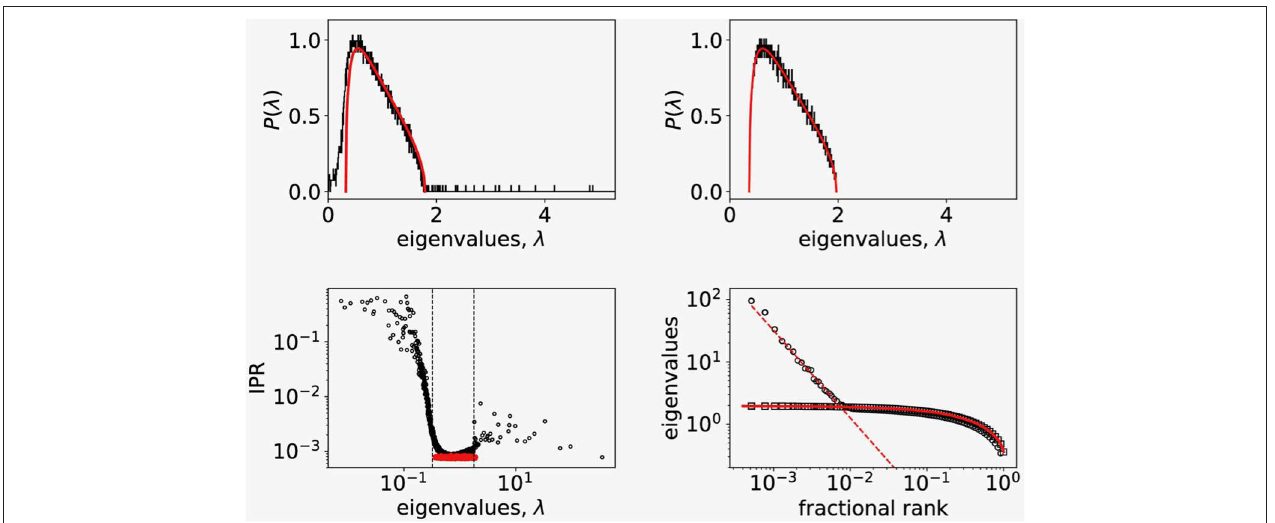
FIGURE 2 | (Top left) Probability distribution of eigenvalues of the empirical correlation matrix for N = 4,000 randomly picked signals (black solid line) compared to the distribution of eigenvalues of random correlation matrix of the same size (red solid line). (Top right) Probability distribution of eigenvalues of the surrogate correlation matrix constructed from shuffled empirical values (black solid line) compared to the random correlation matrix of the same size (red solid line). (Bottom left) Inverse participation ratio plot of eigenvalues showing a random band matrix structure of C with large IPR values at both edges of the eigenvalue spectrum. The dashed vertical lines show RMT bounds. The IPR spectrum for randomized correlations is shown in red. (Bottom right) The fractional rank plot of the entire spectrum of eigenvalues (open dots). For comparison we added the same plot of eigenvalues of correlation matrix computed from randomized data (open squares). The full line shows the fractional rank plot of eigenvalue spectra obtained from distribution given by Equation (3). The shape of the distribution of large eigenvalues points to a scaling